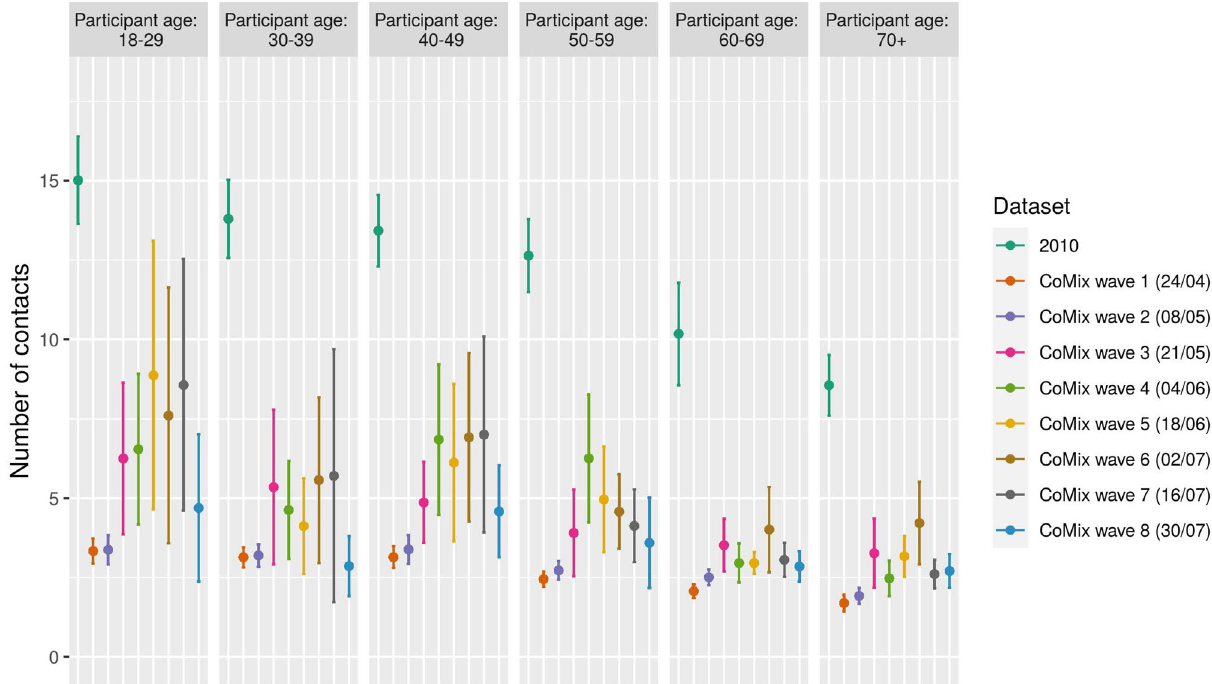
Figure 1. Contacts according to participant age class and dataset. Mean number of contacts broken down by participant age and dataset. For dataset coming from the CoMix survey, the starting date of the data collection is shown in brackets. Errorbars mark the 95% CI.